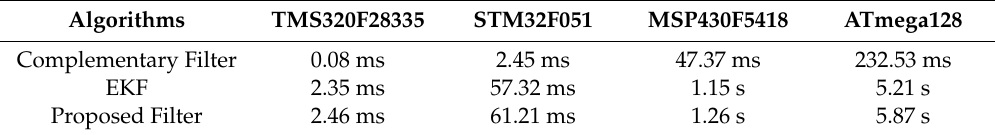
Table 5. Time consumption comparisons of di ff erent algorithms in